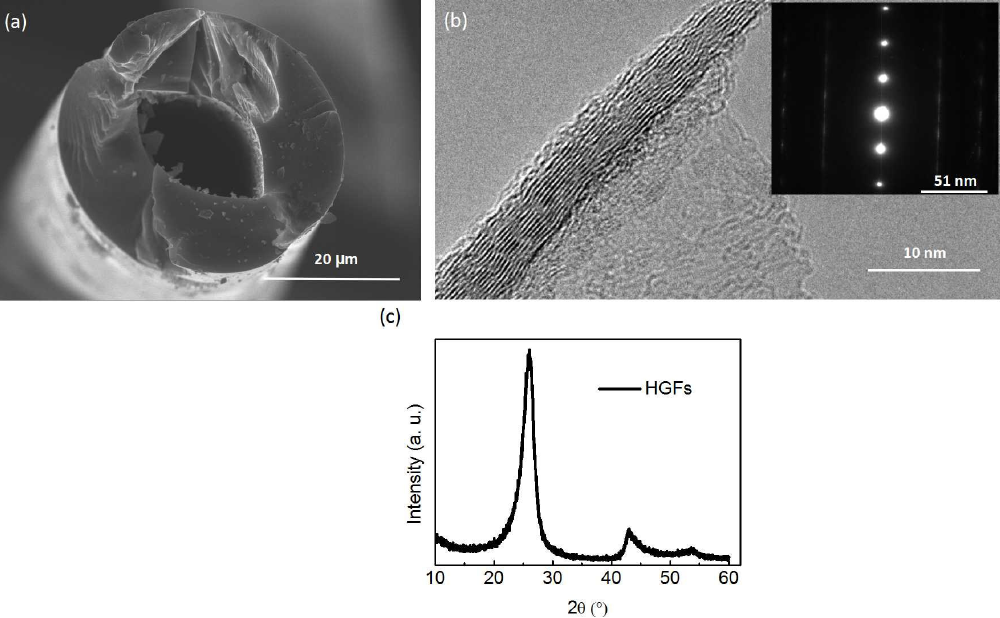
Figure 3. The SEM image of single hollow graphite fiber ( a ). TEM image of the HGFs: ribbons of graphite layer, the inset displays the electron diffraction pattern taken from the entire area ( b ). XRD pattern of the HGFs ( c ).